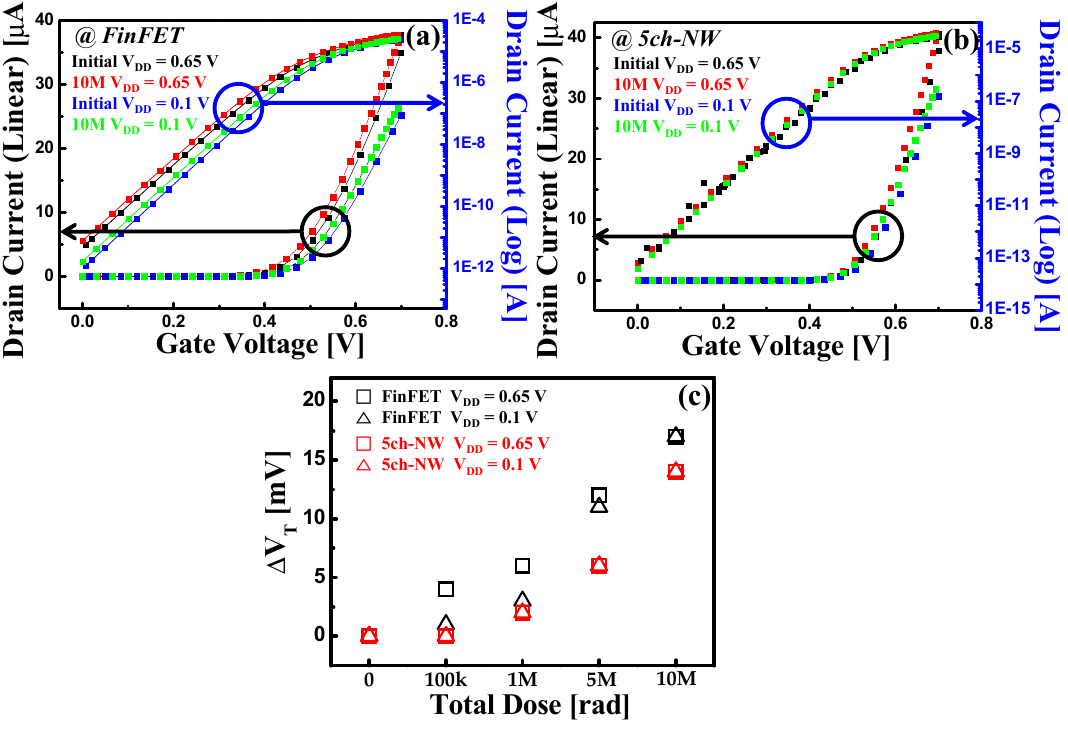
Figure 7. Simulation results according to V DD variation ( a ) FinFET curves, ( b ) 5ch-NW curves. ( c ) Comparison of the V T shifts of FinFET and 5ch-NW.